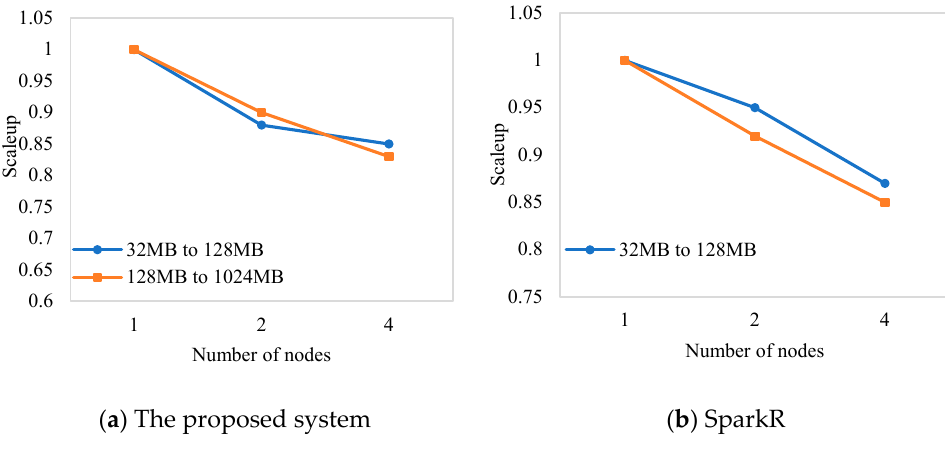
Figure 7. Comparison with regards to scaleup.